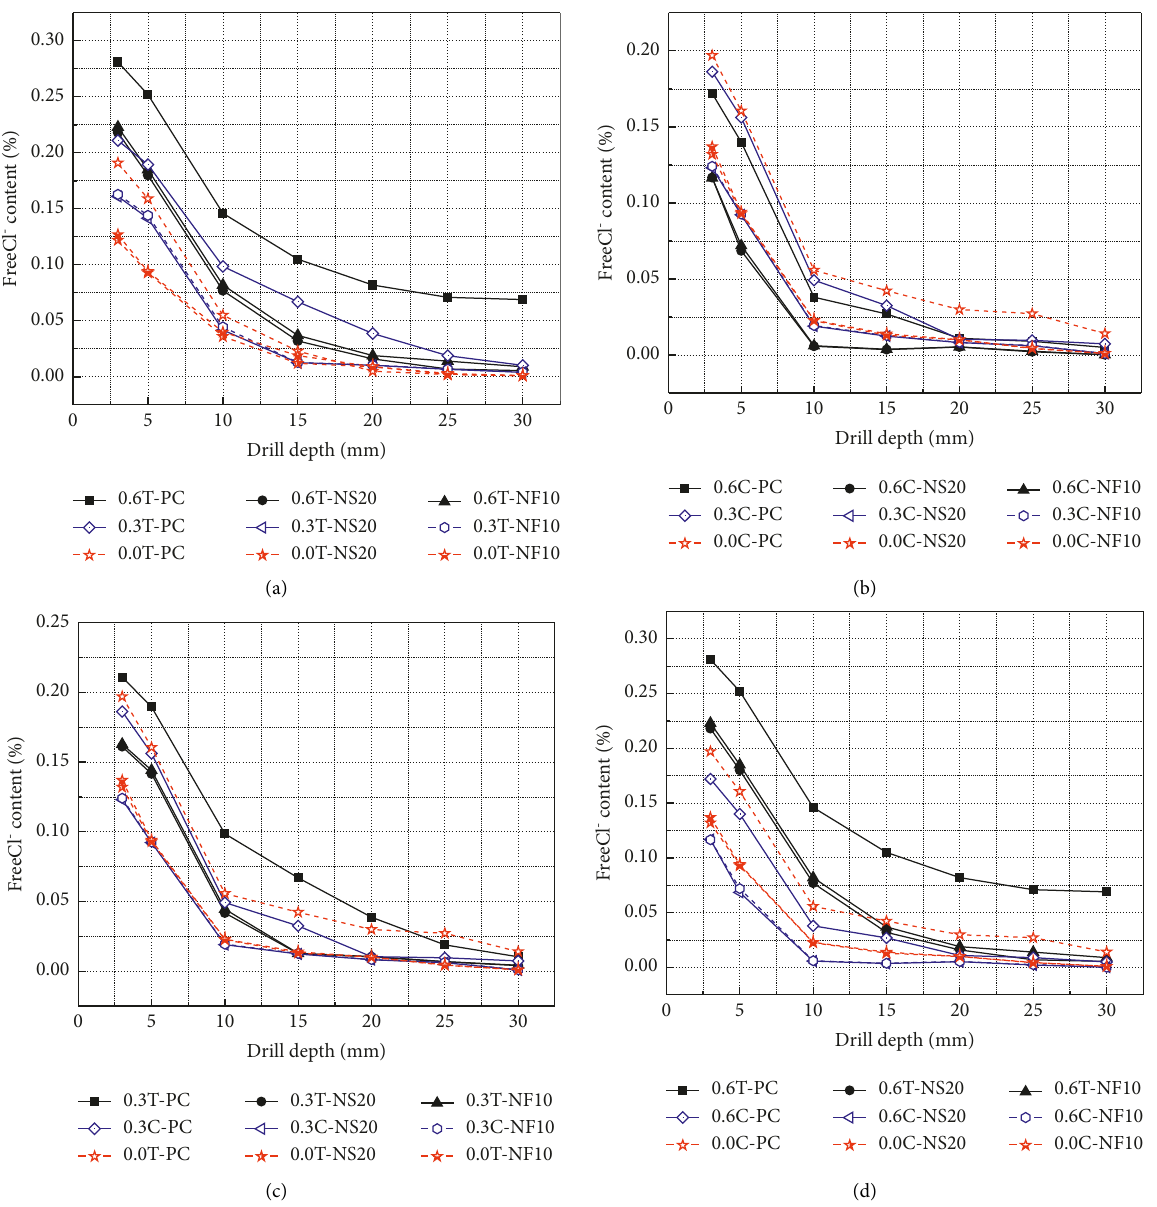
Figure 9: (a) Tensile zone. (b) Compressive zone. (c) Comparison between tensile and compressive zones ( σ � 0.3). (d) Comparison between tensile and compressive zones ( σ �